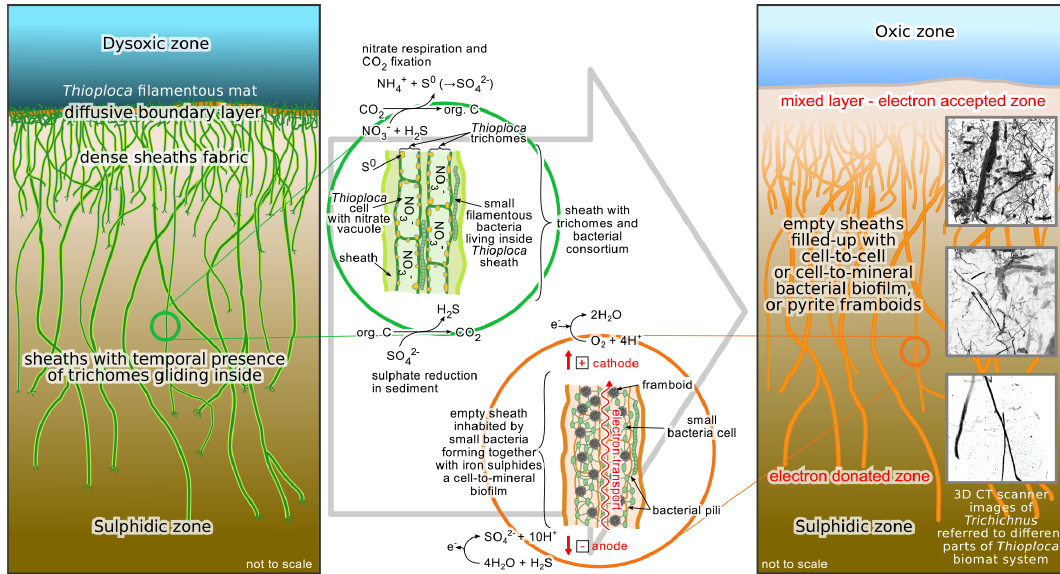
Figure 3. Model of the origin of Trichichnus . The ecology of Thioploca mat system and their sulfide oxidation chemistry (left). The Thioploca sheath system below the diffusive boundary layer forms a construction which may be inhabited by small bacteria making the conductive nanowire–pyrite framboid biofilm. This triggers the electric self-potential between the sulfidic zone and mixed layer, thus, the electron flow (right). The different part of the Trichichnus and the different part of the former Thioploca mat system are shown for comparison (right). Thioploca spp. nitrogen, carbon and sulfur metabolism reactions are taken from Teske and Nelson (2006); half-reactions on Trichichnus are adapted from Nielsen and Risgaard-Petersen